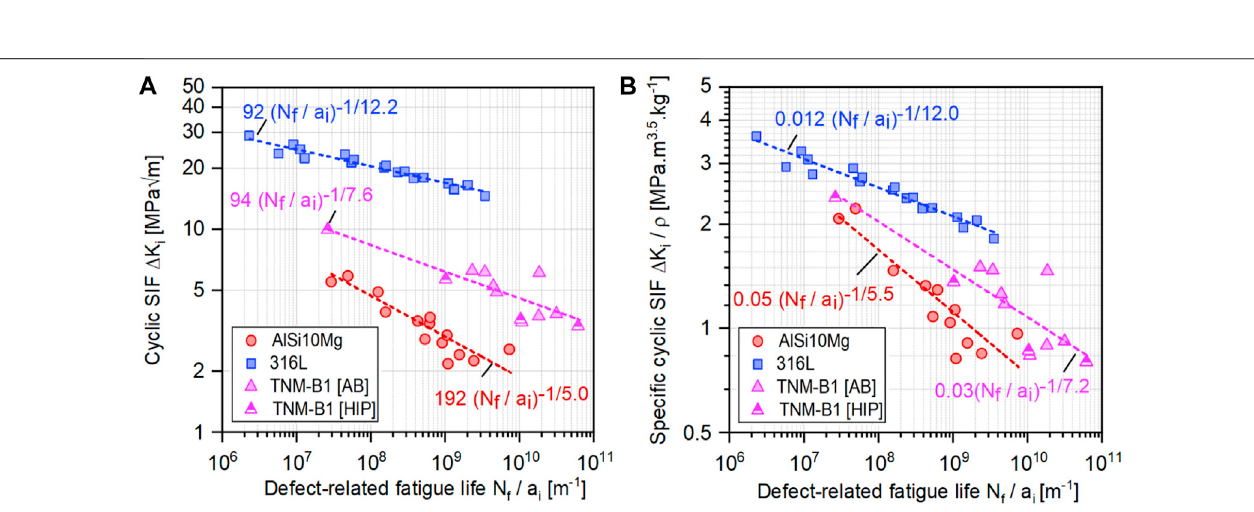
Woehler curve to R 2 = 0.81 in the Shiozawa curve. R 2 improved to 0.94 and 0.72 for 316L and TNM-B1, respectively.